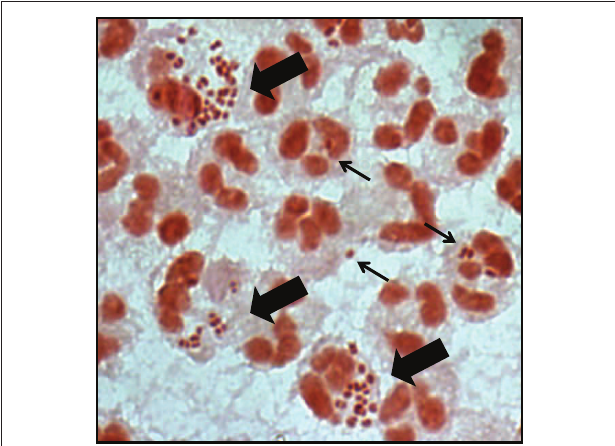
Figure 1 | gonorrhoeal exudates contain numerous PMNs with associated gc. Gram stain of the urethral exudate from a male with uncomplicated gonorrhea. Some PMNs associate with single diplococci (thin arrow), while others have multiple adherent and internalized Gc (thick arrow). Note that the majority of PMNs in the exudate are uninfected.